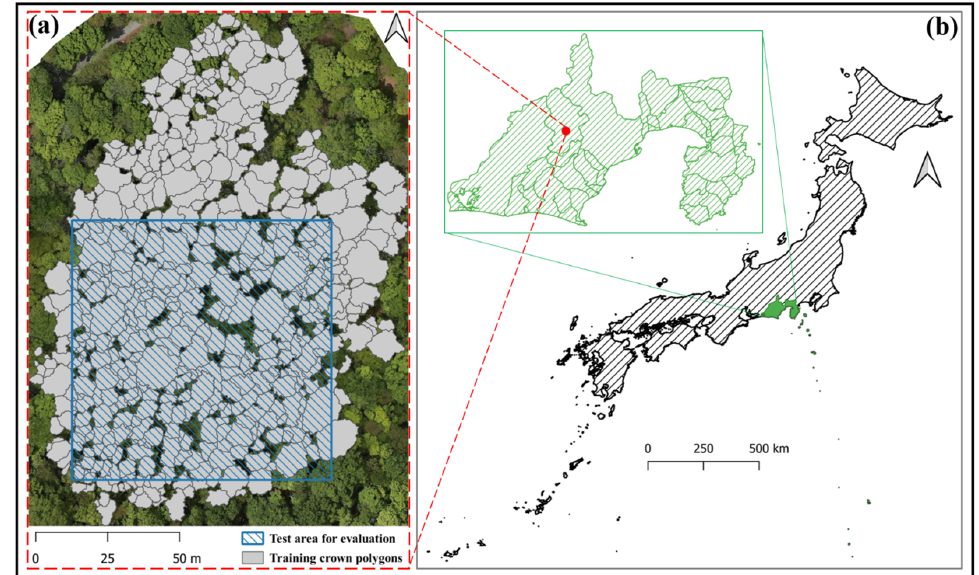
Figure 1. The location of the study area: ( a ) the base data used for transfer training; ( b ) the location of the Nakakawane site, Japan.